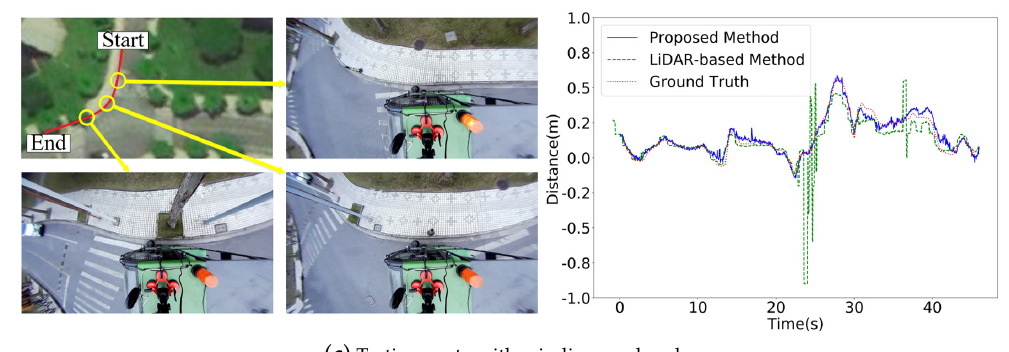
Figure 6. Experimental results with autonomous sweeper. ( a ) testing route with continuous straight curb. The left figure shows the satellite images and sampled scenes. The right figure shows the lateral localization results of the proposed method, LiDAR-based method and ground truth; ( b ) testing route with intermittent straight curbs; ( c ) testing route with winding road